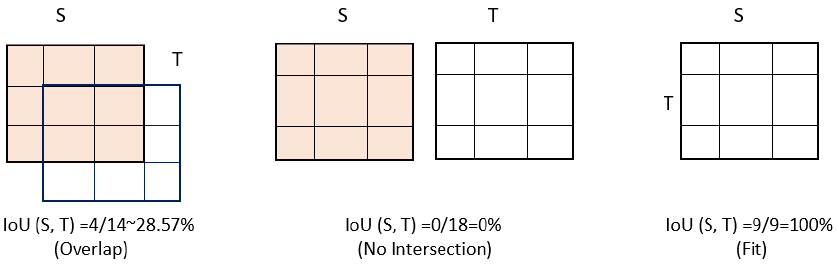
Figure 12. Calculation of IoUs.